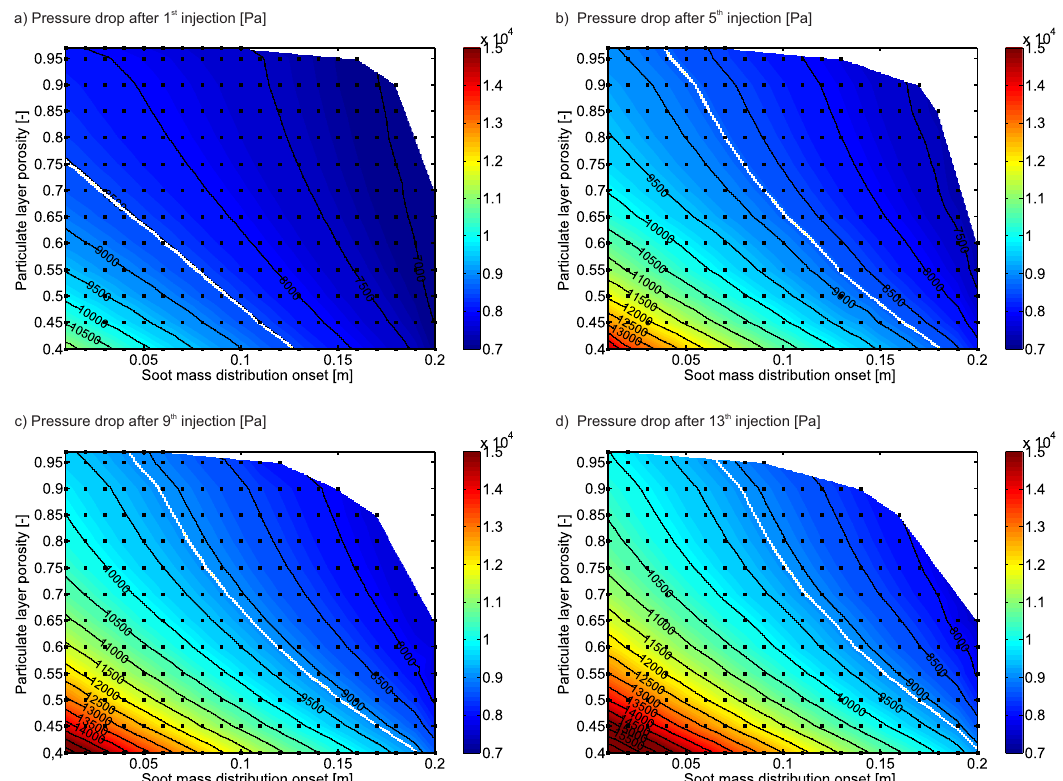
Figure 6. DPF pressure drop as a function of the particulate layer porosity and the soot mass distribution onset after different injection events in DPF